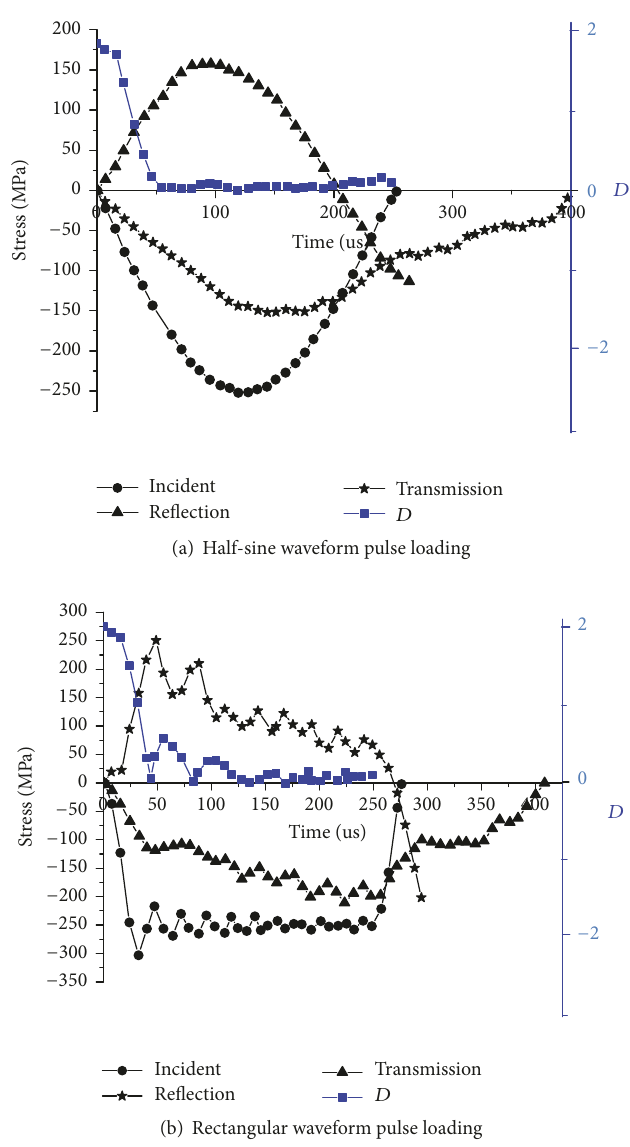
Figure 10: Stress pulses and stress equilibrium equations